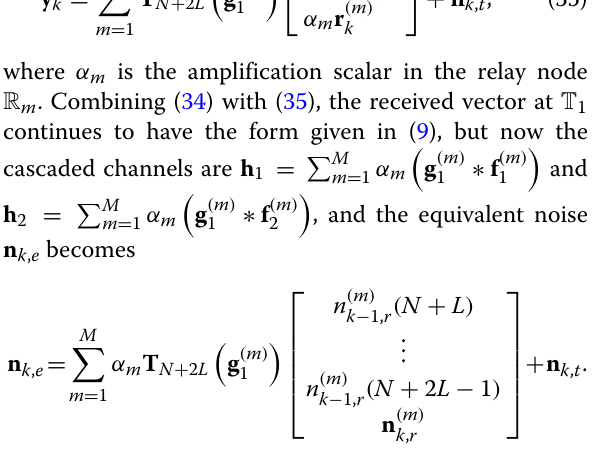
R T m to i be denoted as g